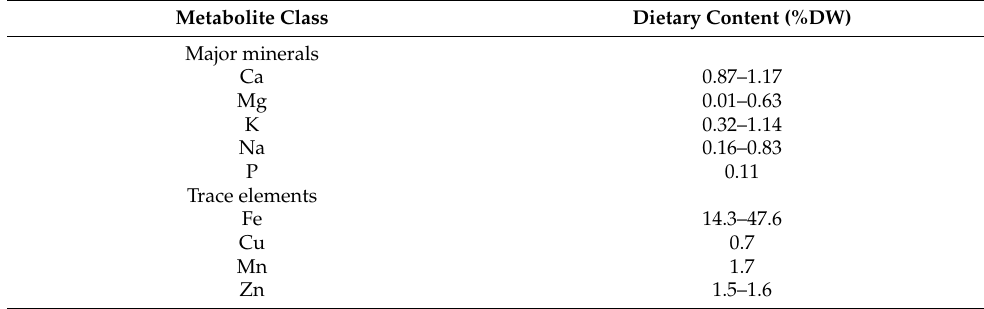
Table 2. Mineral profile of H. fusiformis